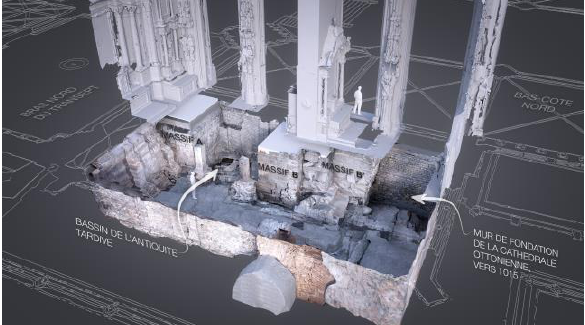
Figure 15. 3D model of the basement combined with the 3D model of the cathedral (courtesy of INSA Strasbourg &